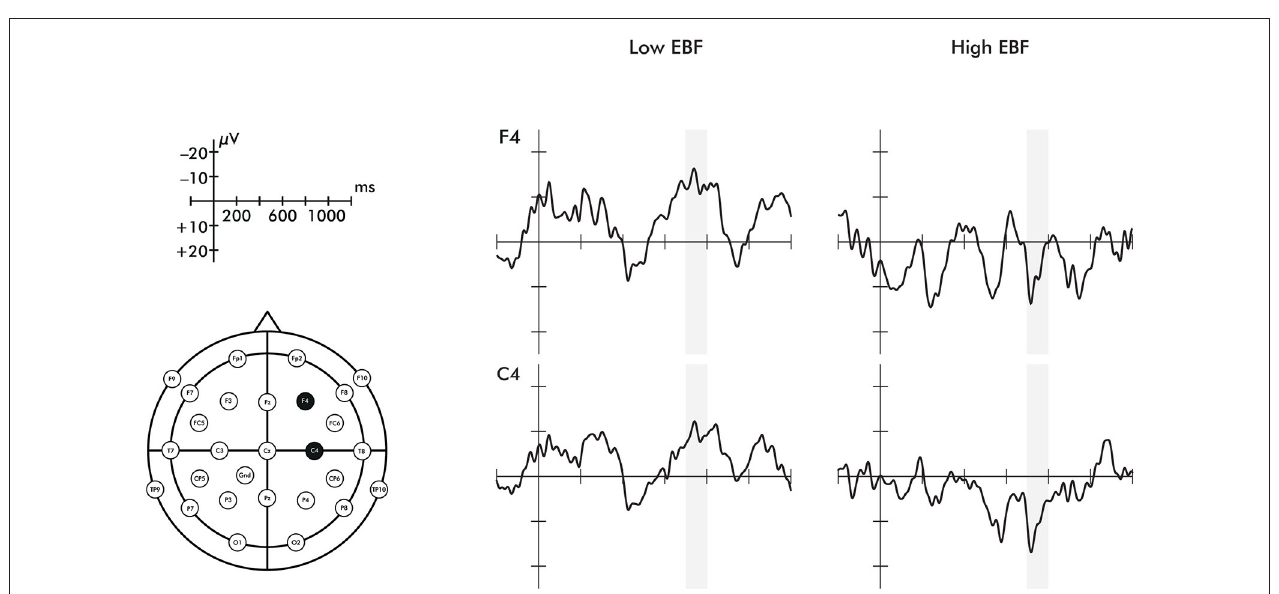
exclusive breastfeeding duration (EBF) group for illustrative purposes, but note that the difference score was treated as a continuous variable in